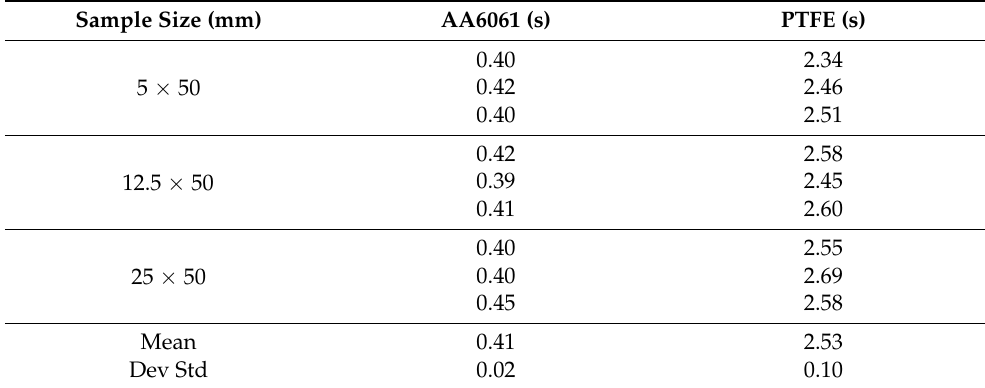
Table 5. Response time data of AA6061 and PFTE samples.